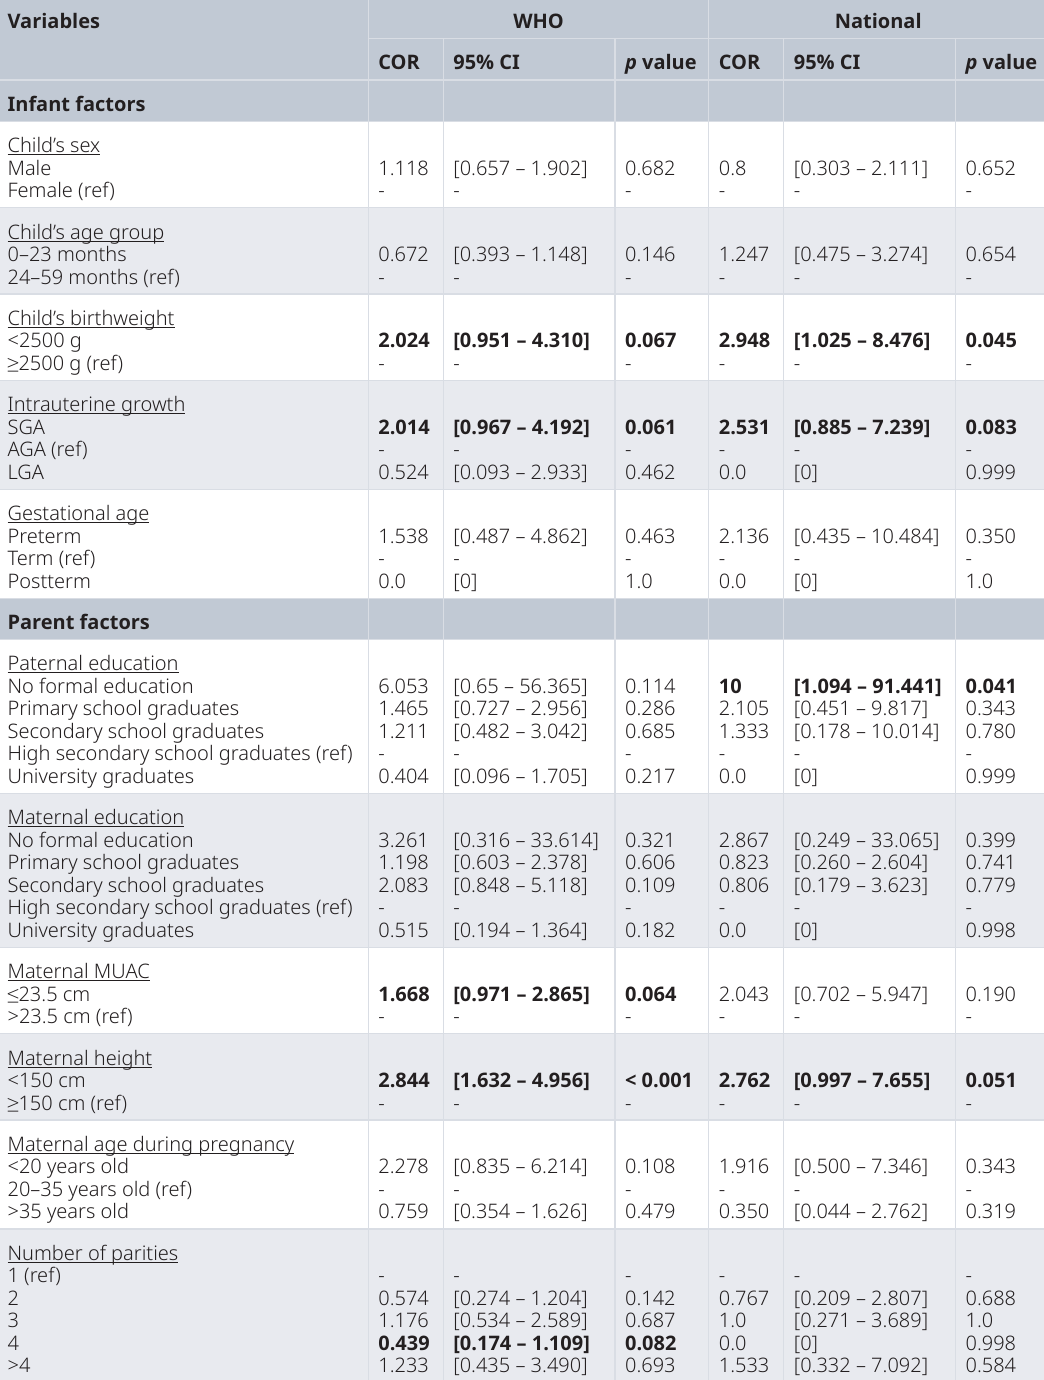
Table 3. Univariate analysis of determinants for stunting among children aged 0–59 months in Musi Sub-district.